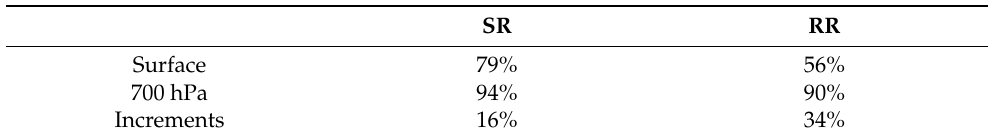
Table 5. Regional average contribution rates of BB emissions over the Southeast Asian region to PM 2.5 concentrations at the surface and 700 hPa over SR and RR, and the regional average increments from the surface to 700 hPa in the two regions. SR RR Surface 79% 56% 700 hPa 94% 90% Increments 16%